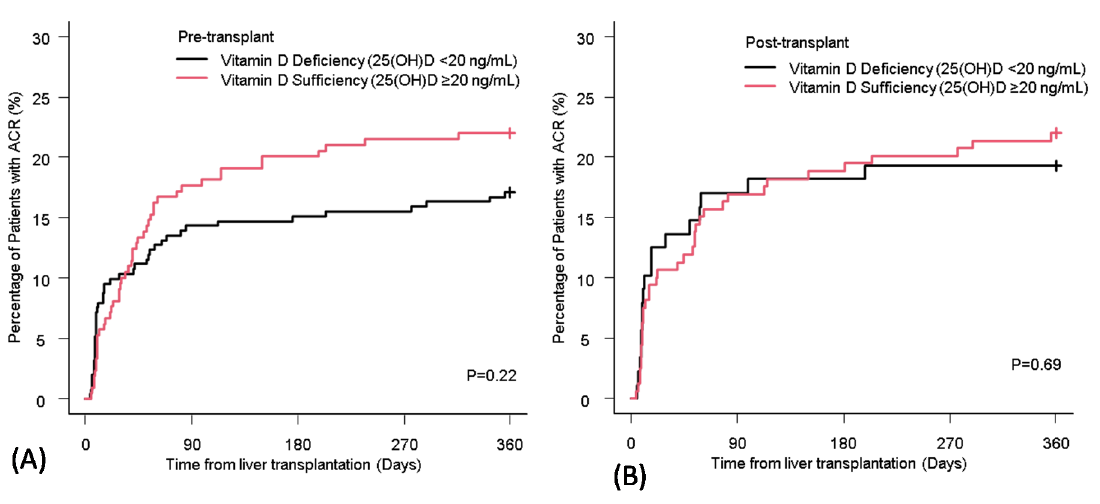
Table 4. Comparison of patient characteristics among different vitamin D supplementation statuses. All Patients ( N = 528) Characteristics